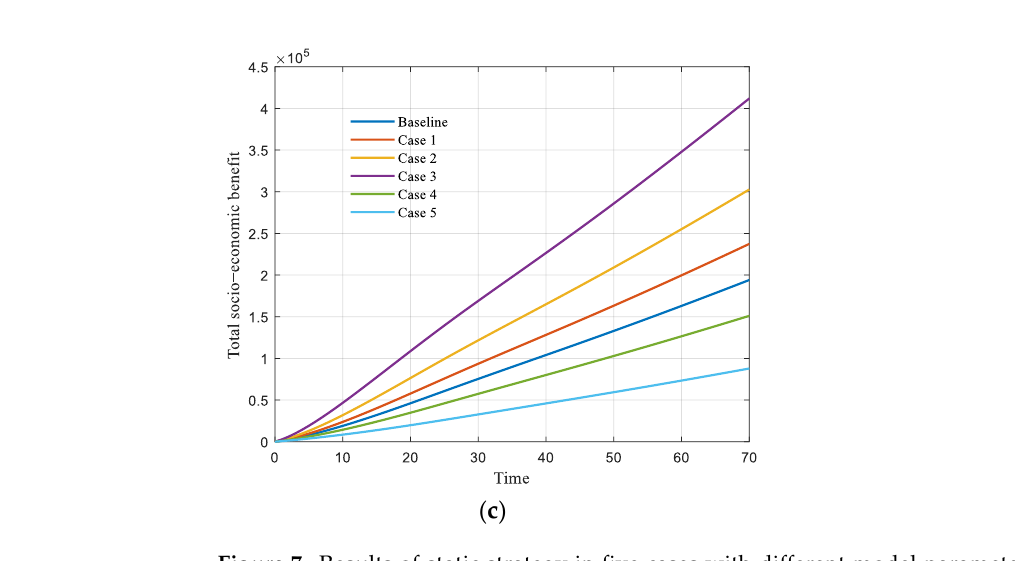
Figure 7. Results of static strategy in five cases with different model parameters. ( a ) Total socio-economic benefit with varying control variables in five cases. ( b ) Level of socio-economic activity along with time in five cases. ( c ) Total socio-economic benefit along with time in five cases.